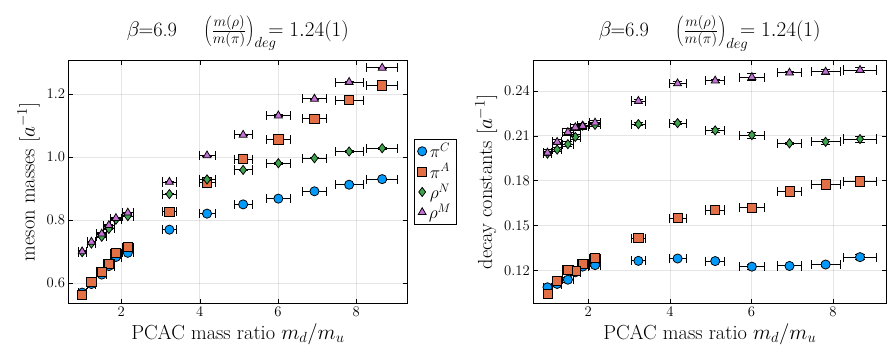
Figure 2. Masses and decay constants of the non-singlet pseudoscalar and vector mesons in lattice units. The unflavoured mesons are always lighter and the corresponding decay constants are smaller. This pattern holds for all other masses and inverse couplings β studied so